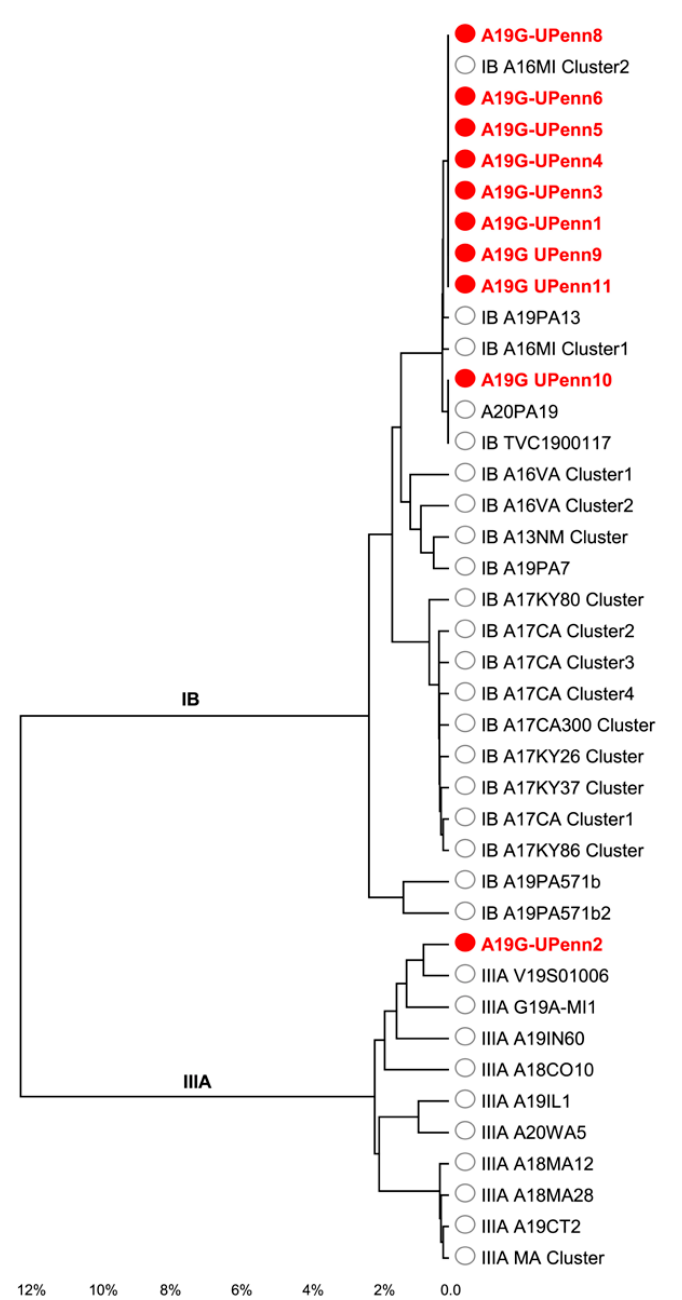
Figure 1. Analysis of outbreak samples. A fragment in the VP1-P2B of the HAV genome was sequenced for genotyping and a phylogenetic tree was constructed using maximum likelihood algorithms. Red circles represent sequenced isolates that were part of an outbreak identified in Philadelphia. White circles represent reference